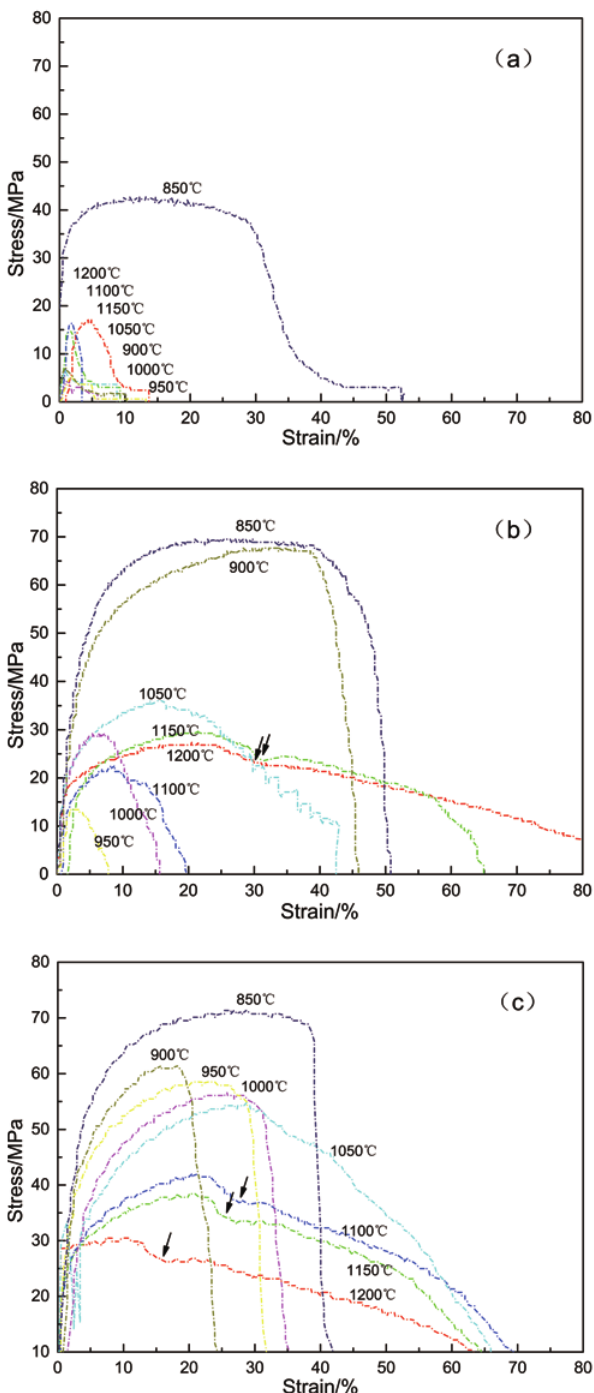
Fig. 4: Flow stress–strain curves as function of tensile temperature for the examined steels (arrows indicate dynamic